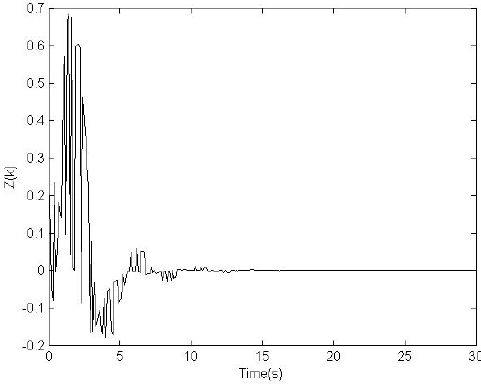
Figure 4. Trajectories of systems (1), (3), (4) with consensus algorithm (19).